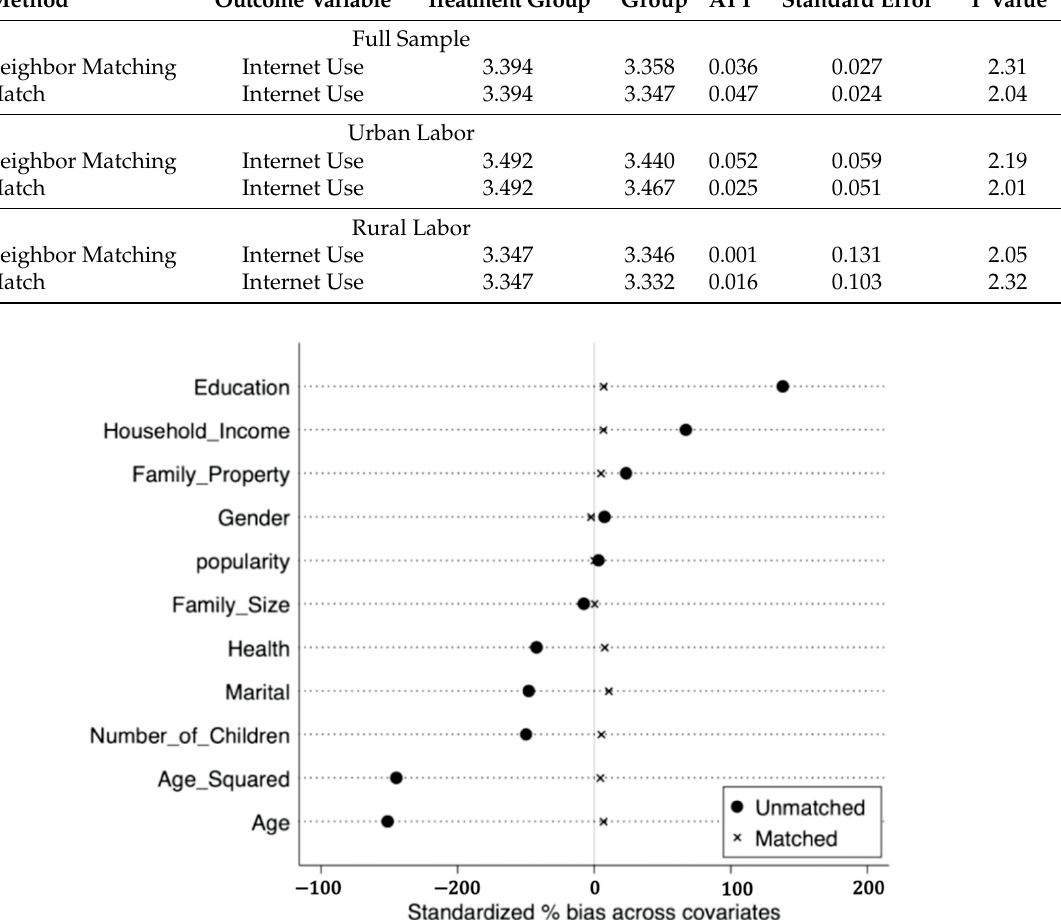
Figure 2. Standardized Deviation Plot for Yes Variables.